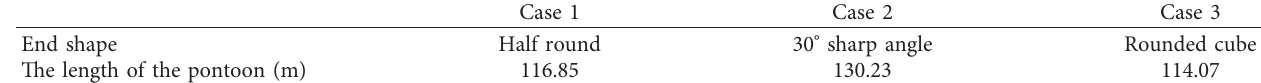
Table 3: The structural parameters of three pontoon end shapes.